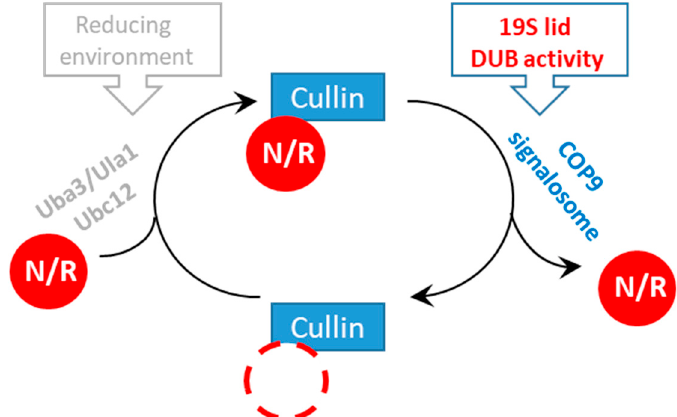
Figure 6. Regulation of Cullin modification cycles by the proteasome. Mutants of the 19S-lid subunit Rpn11 lead to the finding that catalytically active Rpn11 in proteasomes authorizes Cullin deNEDDylation by the CSN.